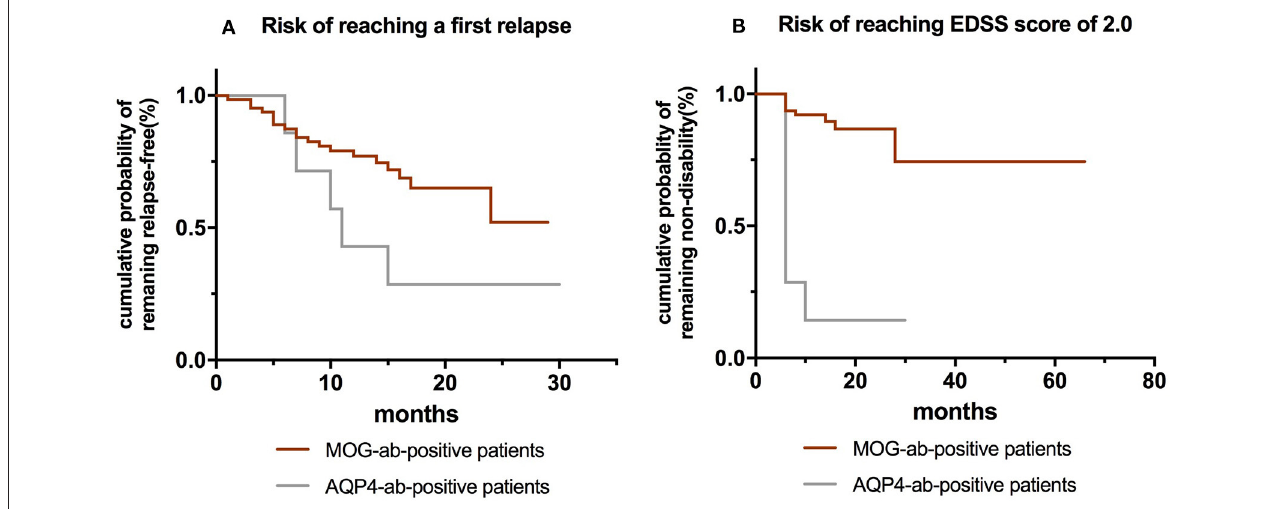
FIGURE 5 | (A) Kaplan-Meier curves showing risk of reaching a first relapse between MOG-ab-positive patients and AQP4-ab-positive patients. (B) Kaplan-Meier curves showing risk of reaching EDSS 2.0 between MOG-ab-positive patients and AQP4-ab-positive patients.